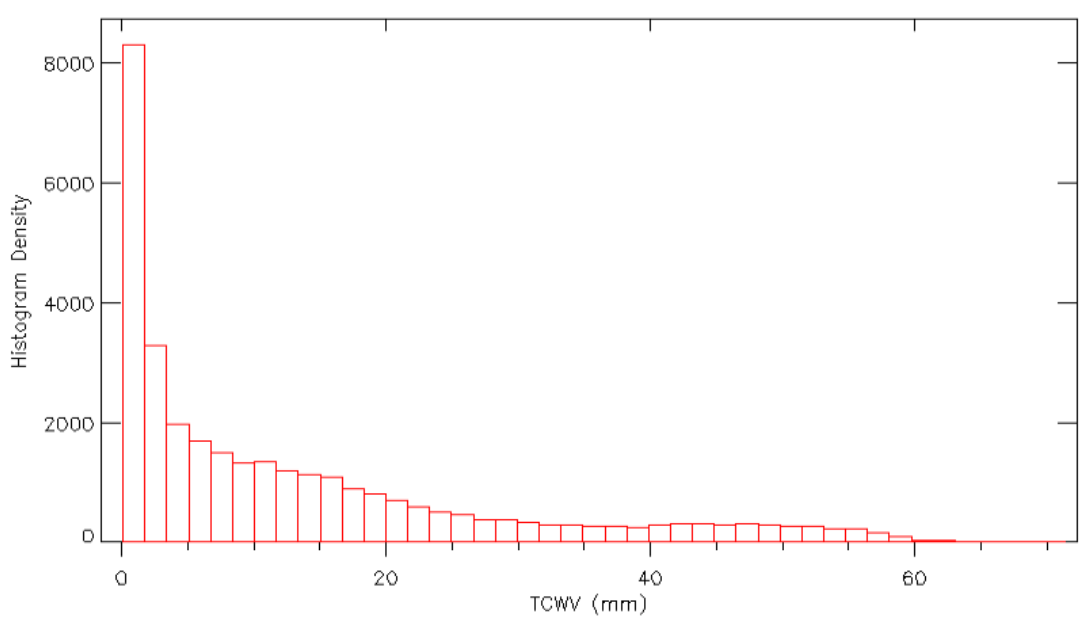
Figure 3. Histogram showing the distribution of TCWV in the selection database (2013). The low TCWV values primarily match the Arctic and Antarctic regions.